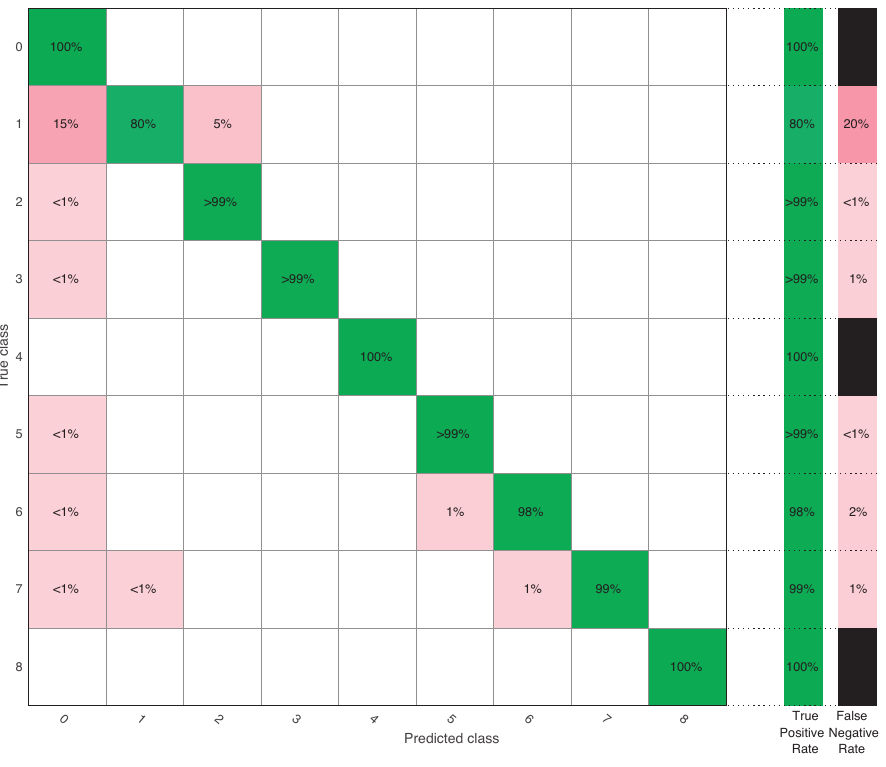
Figure 8. Confusion matrix when J = 10.